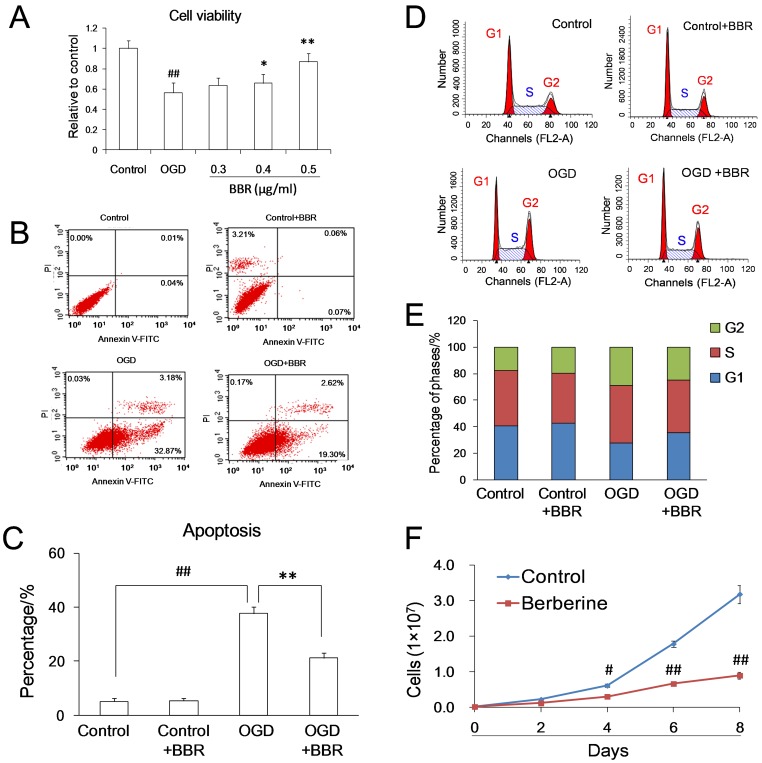
Protective effects of berberine (BBR) in PC12 cells subjected to oxygen and glucose deprivation (OGD).(A) Protective effect of different concentrations of BBR in PC12 cells after OGD as indicated by MTT assay. (B)–(C) Anti-apoptotic effects of BBR in PC12 cells subjected to OGD as indicated using Annexin V-FITC double staining and flow cytometry. (D)–(E) Effects of BBR on cell cycle arrest in PC12 cells subjected to OGD as indicated by flow cytometry. (F) The cell growth curves with and without BBR in different days. The final concentration of BBR was 0.5 µg/ml. BBR was added to the culture 1 h before OGD treatment and throughout reperfusion. # P<0.05 v.s. the control, ## P<0.01 v.s. the control; *P<0.05, **<0.01 v.s. the OGD. Data are presented as mean ± S.D. of six independent experiments (n = 6).